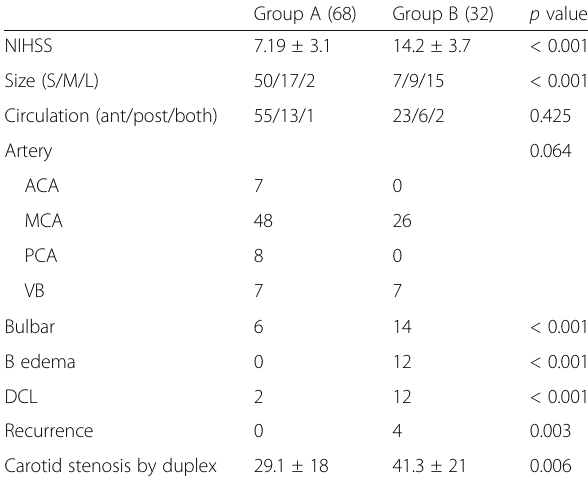
Table 7 Regarding stroke status and occurrence of neurological complications in study patients